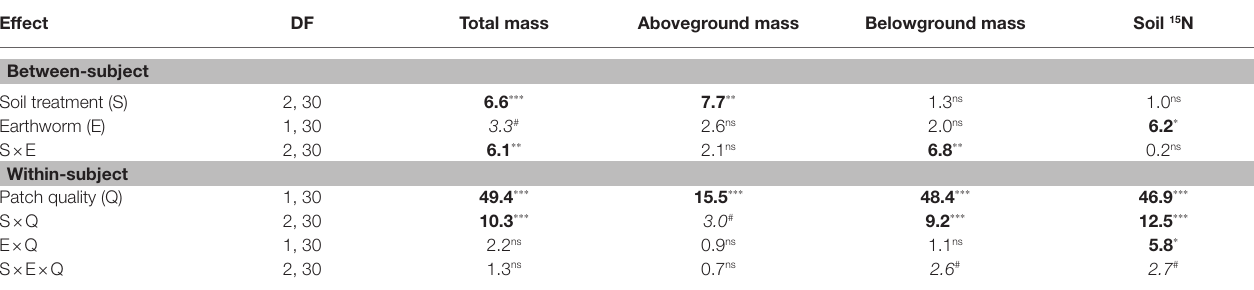
TABLE 2 | Results of ANOVAs for effects of soil treatment (homogeneous vs. heterogeneous small vs. heterogeneous large scale), earthworm (with vs. without) and patch quality (with vs. without added litter) and their interactions on total, aboveground and belowground mass of offspring ramets of Leymus chinensis and 15 N atomic percentage and N concentration in soil at the patch level.